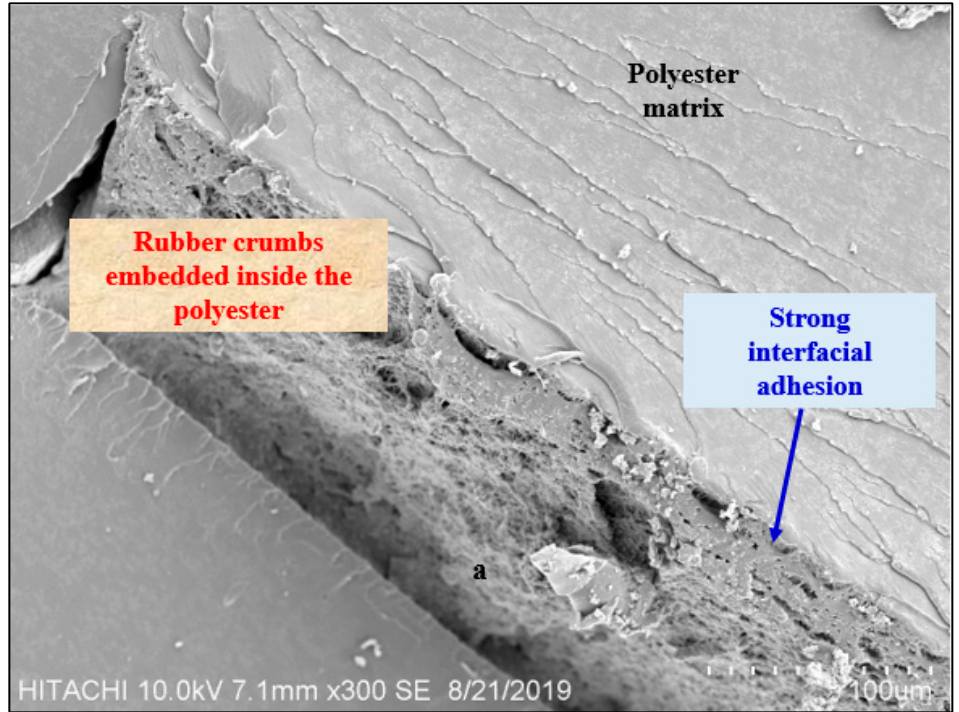
Figure 11. Tensile fracture micrograph of composites with 7% NaOH treated rubber crumbs.